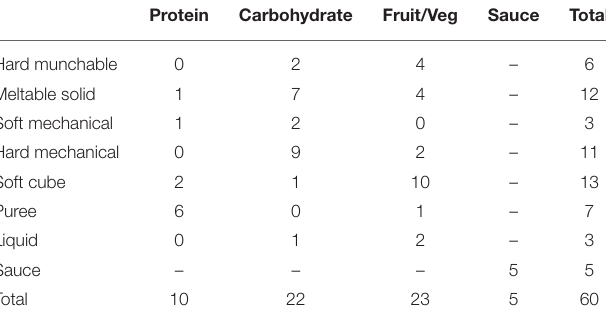
TABLE 1 | Foods available during the intervention by food group and